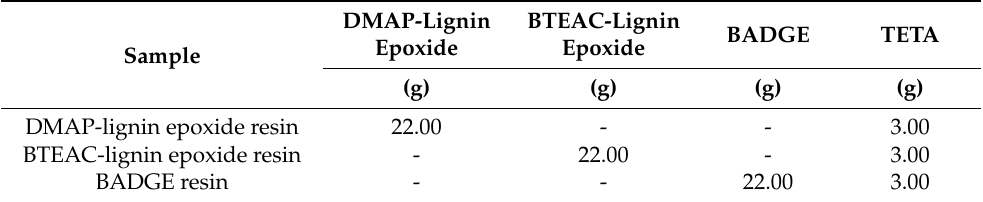
Table 2. The specifications of different types of epoxy resins: the 4-dimethylaminopyridine (DMAP)- lignin epoxide resin, benzyltriethylammonium chloride (BTEAC)-lignin epoxide resin, and bisphenol A diglycidyl ether (BADGE) resin.